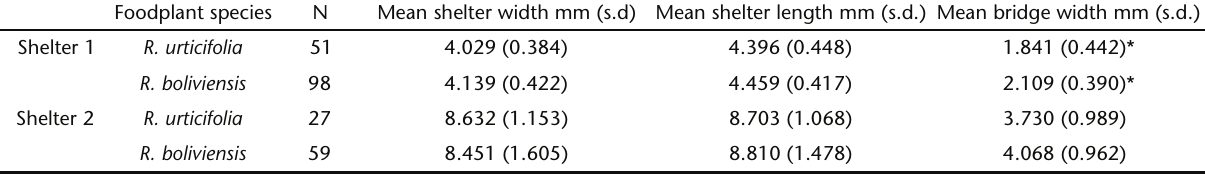
Table I. Measurements of first and second larval shelters of N. haematospila , mean, and standard deviation for each of the three measurements of shelter architecture for first two shelters built by larvae. The size of excised leaf material is constant across both host plant species. Width of the bridge where the leaf is folded is significantly greater in shelters built on R. boliviensis indicating less cutting was required by larvae on this species. Foodplant